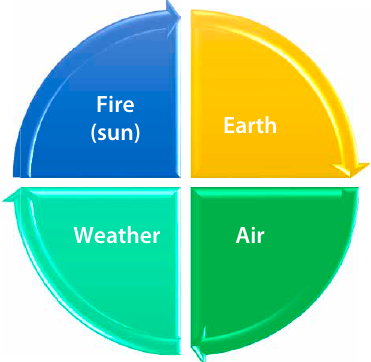
fig. 9. four natural elements from the Iranian viewpoint